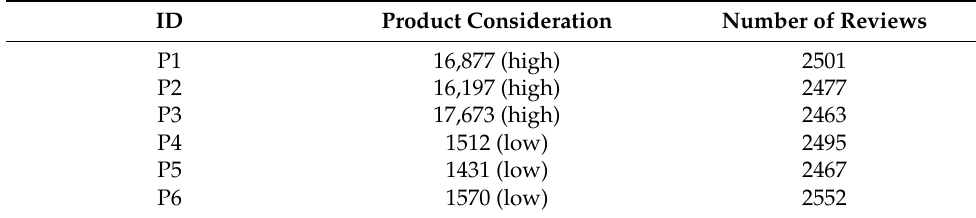
Table 9. Product consideration and review data of six